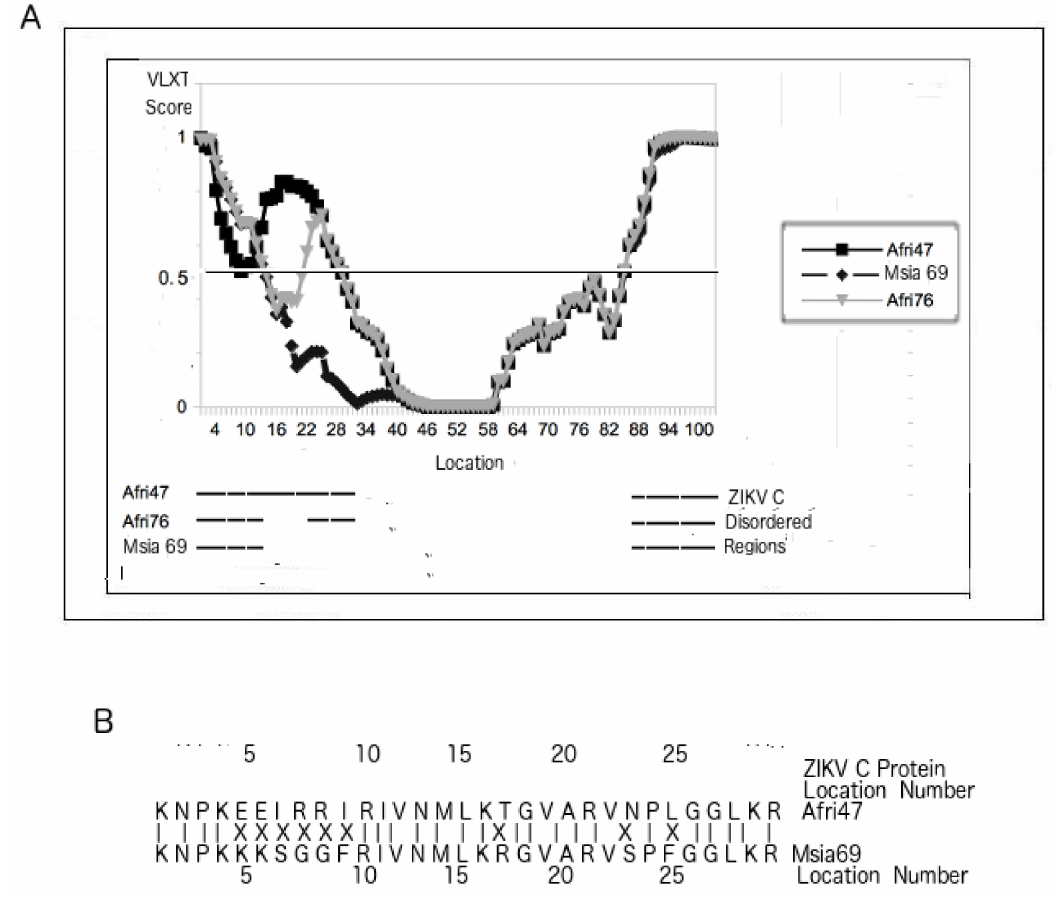
Figure 3. ( A ) Comparison of intrinsic disorder predisposition of the C protein in ZIKV strains. PONDR VLXT plot of C proteins from di ff erent ZIKV strains. ( B ) Mutations and disorder of the N-terminus of the C proteins of the Afri47, Afri76, and Msia69 (the Africa 1947, Africa 1976, and Malaysia 1969 strains, respectively; Afri47 is the ZIKV / Macaca mulatta / UGA / MR-766 / 1947-East_African isolate; see Table 1 for further details) strains. Disorder di ff erences between C proteins from the Asian and African lineages can be traced mainly to mutations and disorder near the